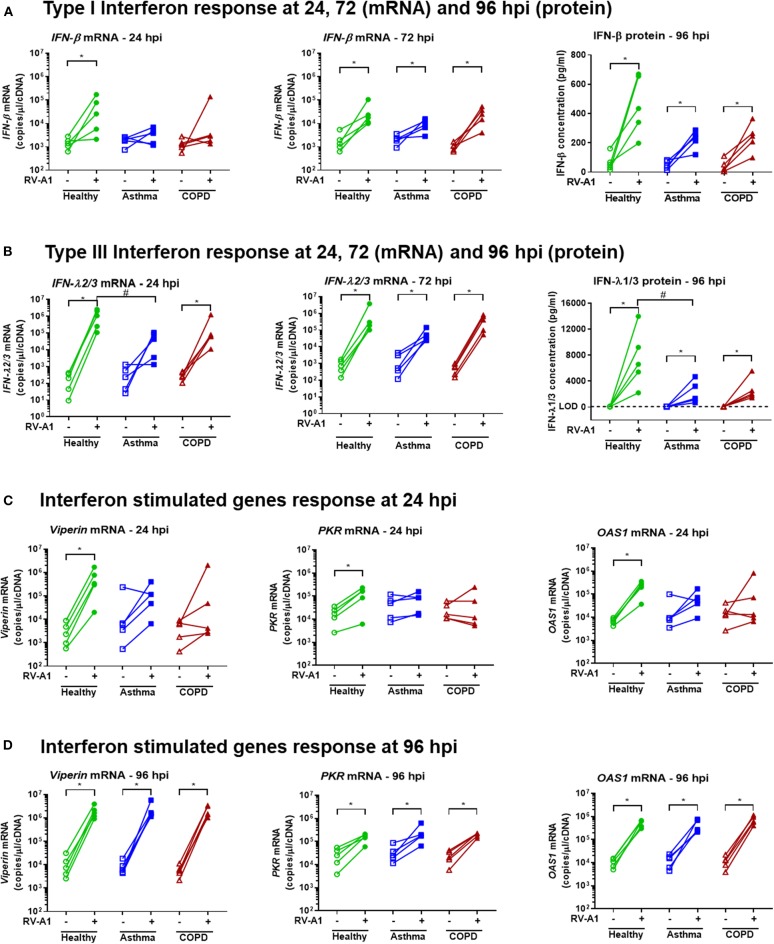
Delayed IFN responses following RV-A1 infection in differentiated BEC cultures generated from asthma or COPD donors, compared to healthy donors. Total RNA and apical culture supernatants were isolated from infected cultures at the timepoints indicated (n = 5 per group). Type I IFN (IFN-β) gene expression at 24 and 72 hpi, and protein levels at 96 hpi (A), type III IFN (IFN-λ) gene expression at 24 and 72 hpi, and protein levels at 96 hpi (B), ISGs (viperin, PKR and OAS1) expression at 24 hpi (C) and 96 hpi (D). Data represented as individual points and analyzed using one-tailed Wilcoxon signed-rank test within the group, *p < 0.05 and Kruskal-Wallis test between groups, #p < 0.05.